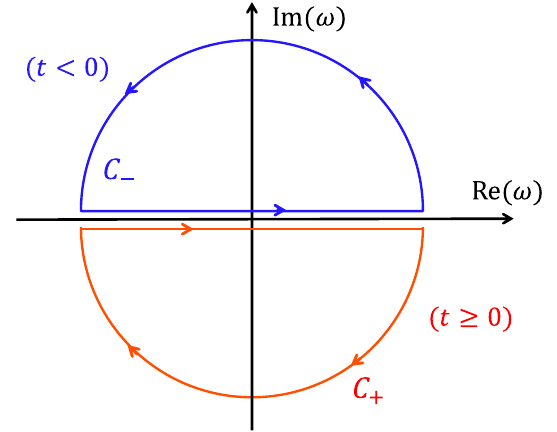
FIG. 3. Schematic of the integral paths in Eq.